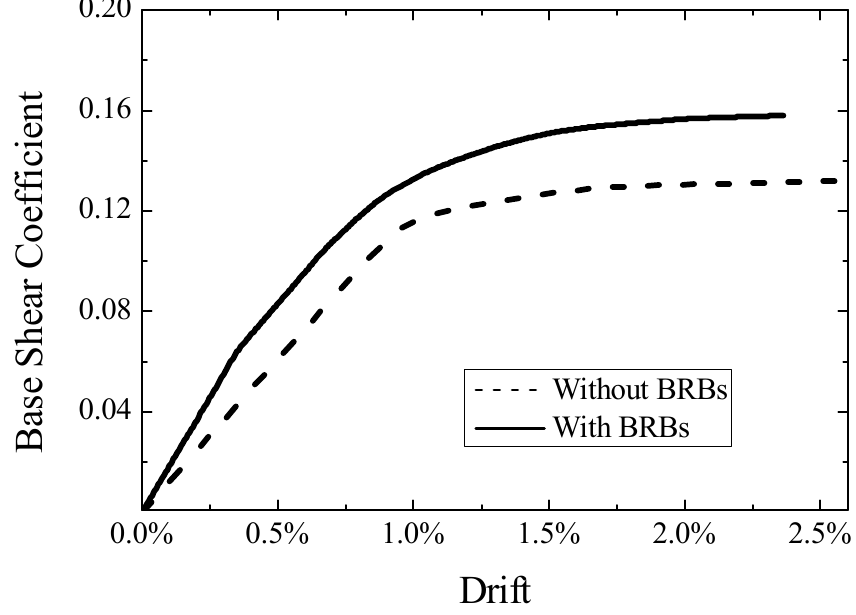
Figure 4. Base shear coefficient and drift ratio at the equivalent height of the target model.